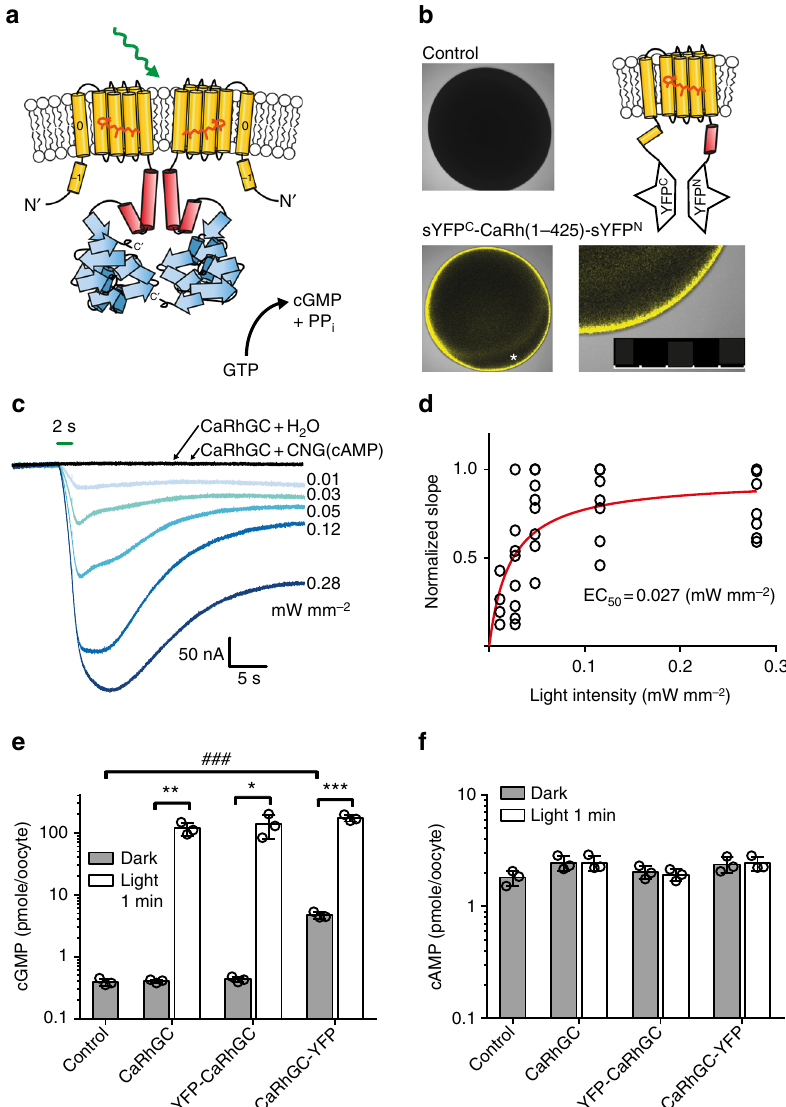
Fig. 1 Activity of CaRhGC in Xenopus oocytes. a Model of the dimeric rhodopsin-guanylyl cyclases from Catenaria anguillulae (Ca). The photo-sensitive rhodopsin domain (yellow) is directly connected to the guanylyl cyclase domain (blue) via a coiled-coil stretch (red). b Single plane confocal images of a non-injected oocyte (top left) and an oocyte expressing the fi rst 1 – 425 aa (CaRh) inserted between the two halves of a split YFP (top right, bottom left, bottom right: *region magni fi ed, scale bar = 500 µ m). YFP fl uorescence is reconstituted in oocytes 3 days after injection. c Representative currents from a Xenopus oocyte, expressing CaRhGC together with the cGMP-sensitive CNGA2 channel in response to green light (blue traces, light 2 s, 560 ± 60 nm, intensities as depicted). No photocurrents were detected in oocytes expressing CaRhGC alone or together with a cAMP-sensitive CNGA2 channel (gray traces, 2 s, 560 ± 60 nm, 0.28 mW mm − 2 ). d Half saturation of current initial slopes (EC 50 ), deduced from c was reached at 0.027mW mm − 2 , the light intensity-response relationship was fi tted exponentially. e , f ELISA-based quanti fi cation of cGMP ( e ) and cAMP ( f ) from whole oocyte lysates. Oocytes expressing untagged CaRhGC, YFP-tagged CaRhGC (N- or C-terminal) were kept in darkness or illuminated with green light (1 min, 532 nm 0.3 mWmm − 2 ). Data are presented as mean ± s.d., n = 3 samples of 5 oocytes each, *** p = 0.0002, ** p = 0.002, * p = 0.02, unpaired t -tests light vs dark. ### p = 0.0001, Dunnett ’ s multiple comparisons vs control (dark conditions, following one-way ANOVA ( p < 0.0001)). Control = non-injected oocytes, CNG = channel cyclic nucleotide-gated intermediate (L1 450 ), which was not observed in the BeRh pho- (L 538 ) (inset Fig. 3a), but caused very little bleaching even after long exposure 17 . To characterize CaRh photocycle intermediates, tocycle 13 . EADS and the extracted time trace at 458 nm (Fig. 3b) absorption changes were recorded from 100 ns to 10 s after sti- revealed accumulation of a second L2 450 state with τ = 397 µs, which converted into the proposed signaling state M 380 with τ = mulation with 10 ns 530 nm laser fl ashes (Fig. 3b, c). Evolution- 31 ms (compared to 8 ms for BeRhGC 13 ). The temporal depen- associated difference spectra (EADS) of the intermediates and dence of the absorbance changes at key wavelengths (Fig. 3c), their life times ( τ values) were extracted using a global fi t routine which refer to the photocycle intermediates, revealed a slower (Fig. 3b). We fi rst detected an early red-shifted K-like photo- decay of the M 380 state ( τ = 571 ms) compared to BeRh ( τ = product K 600 , that rose faster than our time resolution and decayed at pH 7.5 with τ = 0.81 µs into a blue-shifted 100 ms) 13 . In summary, green light converts CaRh D 540 to a red-